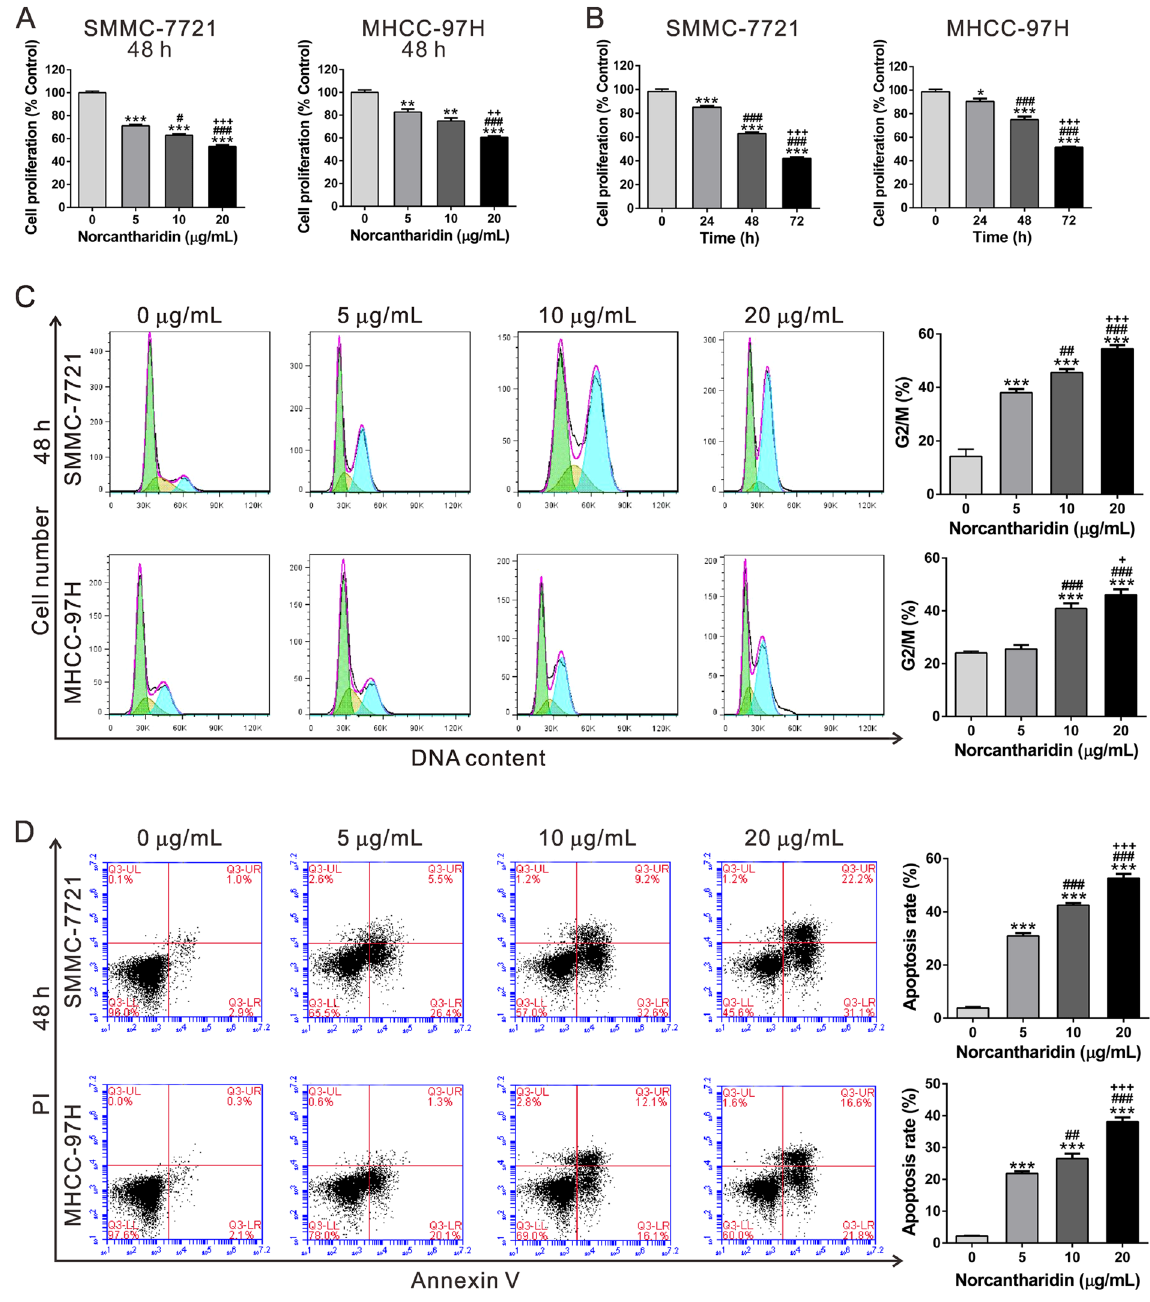
Figure 1. Effects of NCTD on cell proliferation and apoptosis of SMCC-7721 and MHCC-97H cells. ( A ) SMCC-7721 and MHCC-97H cells were treated with DMSO or NCTD (5, 10 and 20 µ g/mL) for 48 h. CCK-8 assay was carried out to assess cell proliferation. The relative cell proliferation was defined as the percentage of cells treated with DMSO (% Control). ** P < 0.01, *** P < 0.001 as compared with DMSO group; # P < 0.05, ### P < 0.001 as compared with 5 µ g/mL NCTD-treated group; ++ P < 0.01, +++ P < 0.001 as compared with 10 µ g/mL NCTD-treated group. ( B ) The cells were treated by 10 μ g/mL NCTD for 24, 48 and 72 h. At the end of incubation, CCK-8 assay was carried out to assess cell proliferation. The relative cell proliferation was expressed as the percentage of OD 450 compared with that of the control (% Control). * P < 0.05, *** P < 0.001 as compared with 0 h; ### P < 0.001 as compared with 24 h; +++ P < 0.001 as compared with 48 h. ( C,D ) SMCC-7721 and MHCC-97H cells were treated with DMSO or NCTD for 48 h. Cell cycle ( C ) distribution was assessed by PI staining and flow cytometric analysis. Cell percentages in G2/M phase were shown here. Cell apoptosis ( D ) was evaluated by Annexin V-FITC/PI staining followed by flow cytometric analysis. Cells in the lower right quadrant are Annexin V-positive and PI-negative staining, representing the early apoptotic cells. *** P < 0.001 as compared with DMSO group; ## P < 0.01, ### P < 0.001 as compared with 5 µ g/mL NCTD-treated group; +++ P < 0.001 as compared with 10 µ g/mL NCTD-treated group. All experiments shown were performed independently at least three